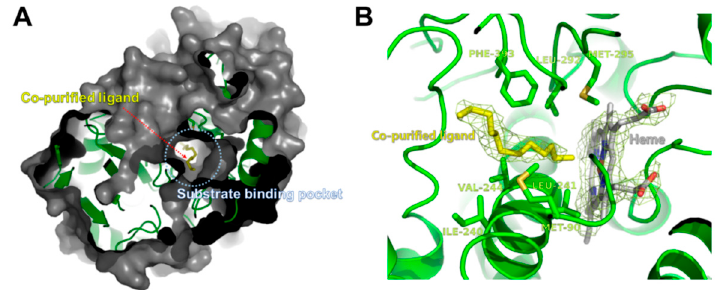
Figure 4. Co-purified ligand in the substrate-binding pocket of CYP153D17. ( A ) The co-purified ligand molecule is represented as a yellow stick, along with the surface representation of CYP153D17; ( B ) The CYP153D17 residues involved in interactions with the co-purified ligand are represented by green sticks. 2Fo-Fc electron density map at 1.0 σ was shown around co-purified dodecane-like molecule and heme group.